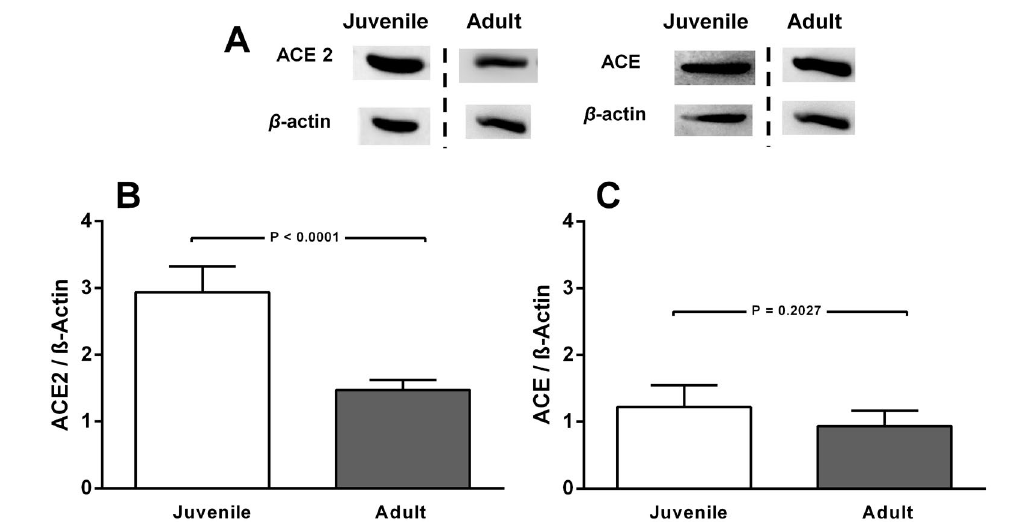
Figure 1. ACE2, but not ACE levels decrease in normonourished CTR rats aged 90 days (juvenile) compared to CTR 162 days- old rats (adult). A. Representative immunoblottings from renal cortex corticis of juvenile and adult rats, with β-actin as the loading control; B and C. bargraph representation of ACE2 and ACE levels in renal cortex corticis of juvenile and adult rats. Bars indicate mean ± SEM ( N = 4-8 different membrane preparations). Statistical differences were estimated by unpaired Student’s t -test. P values are indicated within the panels. Differences were set at P < 0.05. In A, the representative blots from juvenile and adult rats were the same for ACE2 and ACE. Cutting was unavoidable because different studies are being compared. They were carried out by using CTR diets along different periods of life. Loading controls were run on the same blot as the representative ACE and ACE2 images. The vertical dashed lines indicate that images come from blots that were run and scanned at different